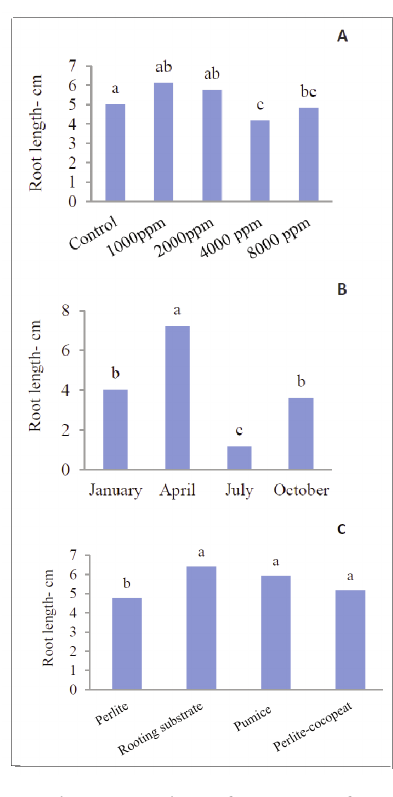
Fig. 8 ­ A, B, C The mean values of rooting performance in roo­ ted cuttings (root length) within for the 5 treatments of indole butyric acid, 4 season and 4 substrates. The mean values with the same letter were not different at level 0.05 according to the LSD test. Sample data: 540 cuttings for each substrate.